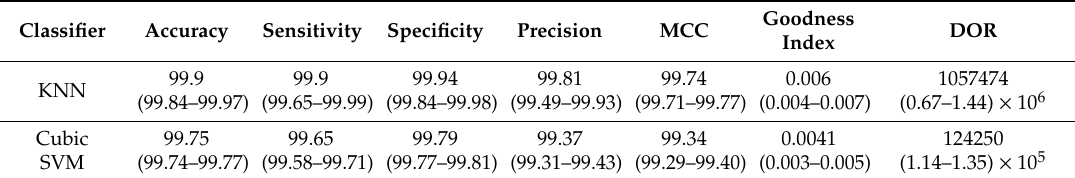
Table 8. Performance metrics (95% CI) for detecting stress and non- stress with Fp1 and Fp2 electrodes using five-folds cross validation.